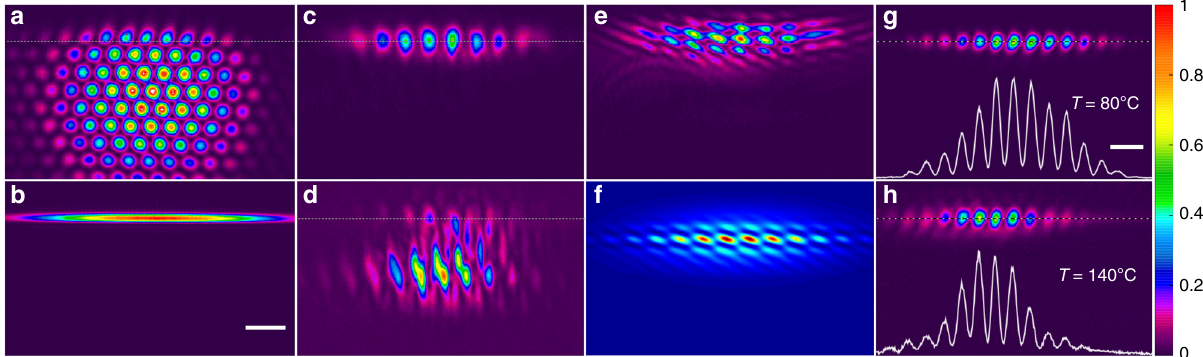
Fig. 2 Experimental demonstration of the edge state at the zigzag edge. a Interference pattern of three coupling beams creating the lattice with a lattice constant of 112 μ m . This hexagonal lattice induces the honeycomb lattice in Fig. 1e under EIT conditions. The edge marked by the dotted line corresponds to zigzag edge. b The incident stripe probe beam. Scale bar: 200 μ m. c The edge state excited by the probe beam at Δ 1 ¼ 135 MHz with the probe power being 100 μ W . d Diffraction of the probe beam into the bulk of the lattice at Δ 1 ¼ 105 MHz . e Interference pattern of the output probe beam from panel c with a reference beam illustrating staggered phase of the edge state. a – e share the same scale bar de fi ned in ( b ). f Theoretical interference pattern calculated for extended linear edge state. g , h Output probe beams for different temperatures (effectively corresponding to different propagation distances) at Δ 1 ¼ 135 MHz revealing motion of the edge state. White lines at the bottom show intensity pro fi les of the probe beam along the dashed lines. Considering the absorptive nature of atomic medium, the linear gain g (which only affects the visibility, but not the pro fi le of the beams) of the CCD camera is used to improve the appearance of fi gures. The CCD gain for ( g ) and ( h ) are g ¼ 0 (no gain) and g ¼ 8, respectively. Scale bar: 200 μ